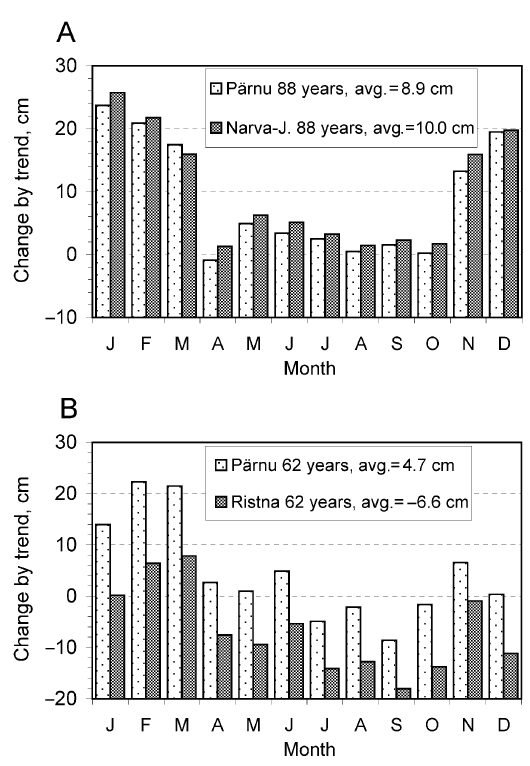
Fig. 6. Seasonal structure of mean sea level changes by linear trend at Pärnu and Narva-Jõesuu for 19242011 ( A ), and at Pärnu and Ristna for 19502011 ( B ). The trend slopes are multiplied with the number of years, 88 in ( A ) and 62 in ( B ). The change values partially reflect the influence of land uplift, which is fastest at Ristna.